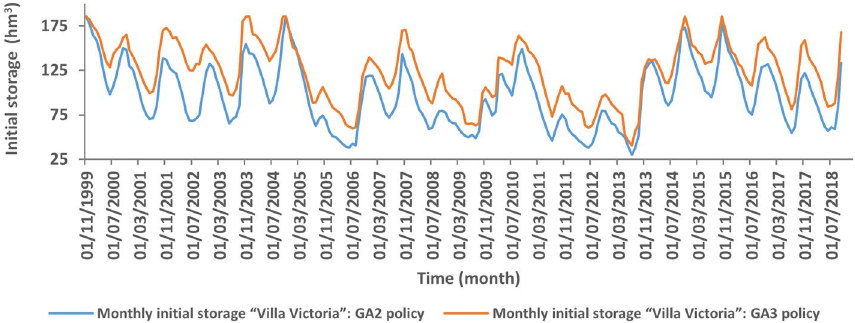
Fig. 20 The total monthly initial storage of the three main reser‑ voirs with GA2 and GA3